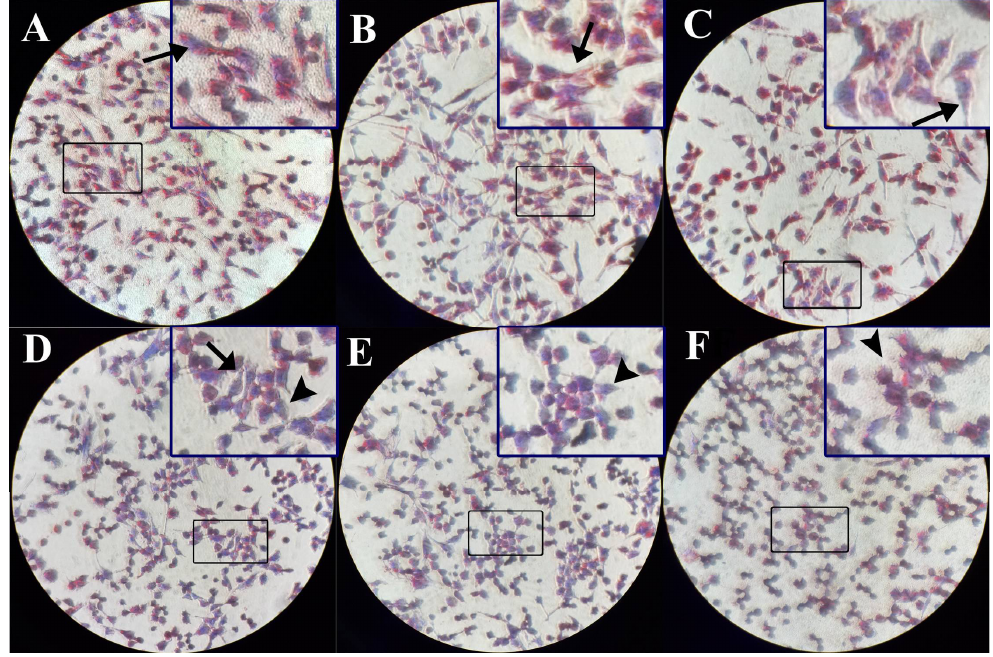
Figure 2. Intracellular triglyceride (TG) stained by oil-red o (ORO) after treatment with different concentrations of DBTD. The ORO kits stain the lipid red and nucleus blue, respectively, to facilitate our observation of lipid droplets. ( A ) 0 μmol/L, ( B ) 0.13 μmol/L, and ( C ) 0.25 μmol/L DBTD-treated cells have large red stained sections and have normal morphology stretching in fibrous shapes (arrow). ( D ) 0.50 μmol/L, ( E ) 1.00 μmol/L, and ( F ) 2.00 μmol/L DBTD-treated cells have diminished red areas and turn to a global appearance, which indicates low viability (arrow head). Original magnification ×100. Table 2. The absorbance of oil-red o dye dissolved in isopropanol.